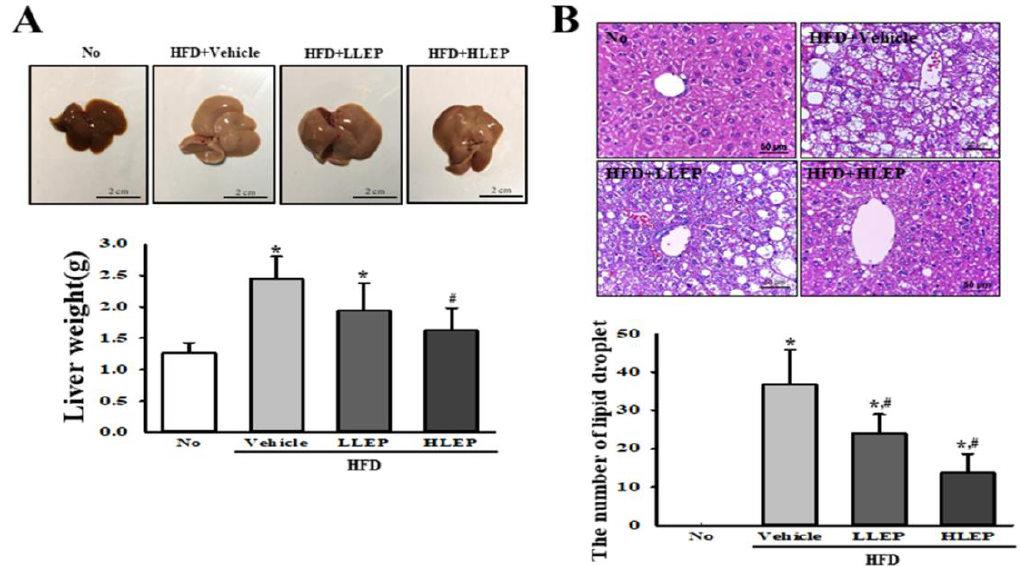
Figure 3. Measurement of liver weight and lipid droplet number in liver slide sections. ( A ) Livers collected from HFD-induced obese C57BL/6N mice, the subsequent to treatment with No, Vehicle, LLEP, or HLEP, were weighed using an electrical balance. Three to five mice per group were used for collecting livers, and their weight was measured in duplicate for each sample. ( B ) Lipid droplets were detected in H&E stained fat sections at 200× magnification, and the total number of lipid droplets was measured using the Leica Application Suite. Five to six mice per group were used for the preparation of H&E stained tissues, and the number of lipid droplets was counted in duplicate for each slide. Data represent the mean ± SD. * p < 0.05 compared to the No-treated group. # p < 0.05 compared to the HFD + Vehicle-treated group. Abbreviations: HFD, high-fat diet; LLEP, low concentration of LEP; HLEP, high concentration of LEP.